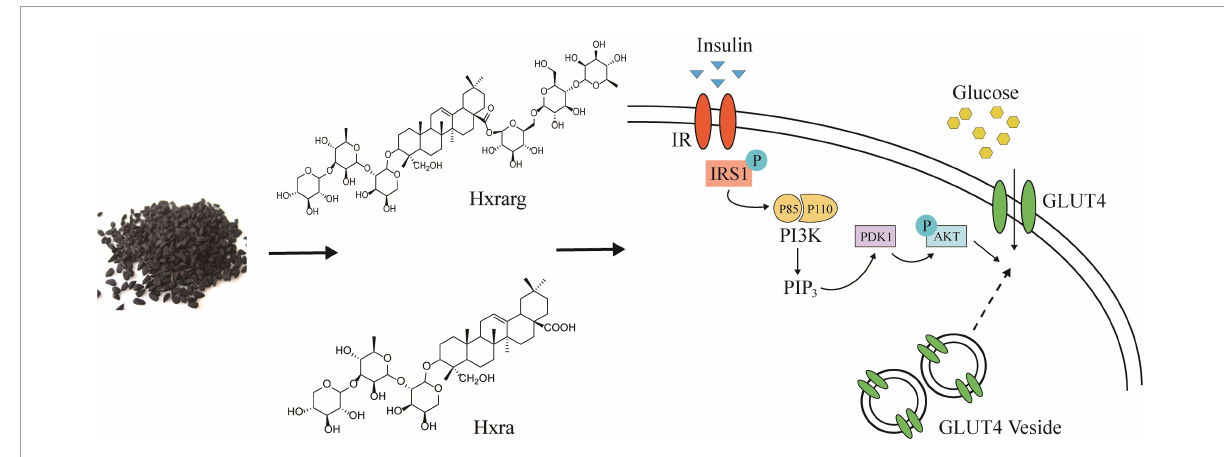
FIGURE10 Hxrarg and Hxra activate PI-3K/AKT signaling pathways to promote the translocation of